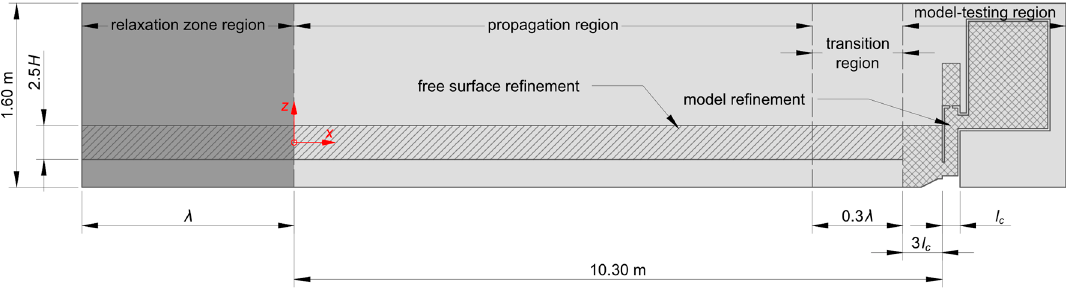
Figure 3. Sketch of the computational domain.